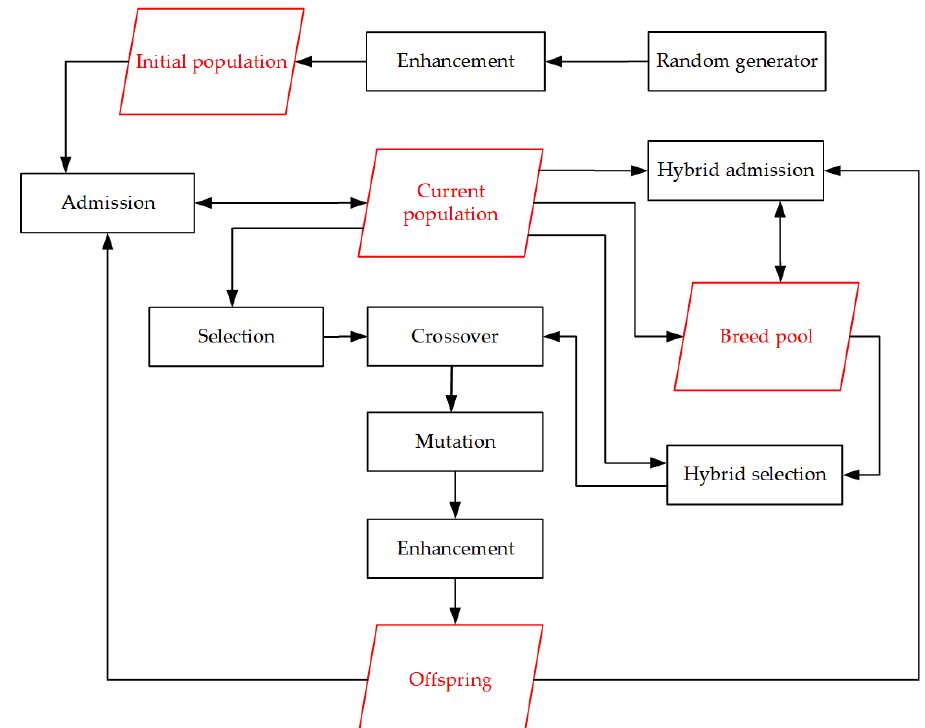
Figure 4. The operation principle of our proposed hybrid genetic algorithm for solving the two-stage supply chain network design problem with fixed